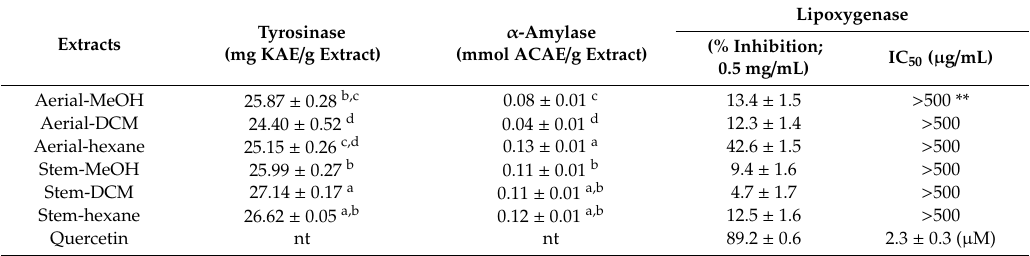
Table 4. Enzyme inhibition potential of aerial and stem extracts of B. papillosa